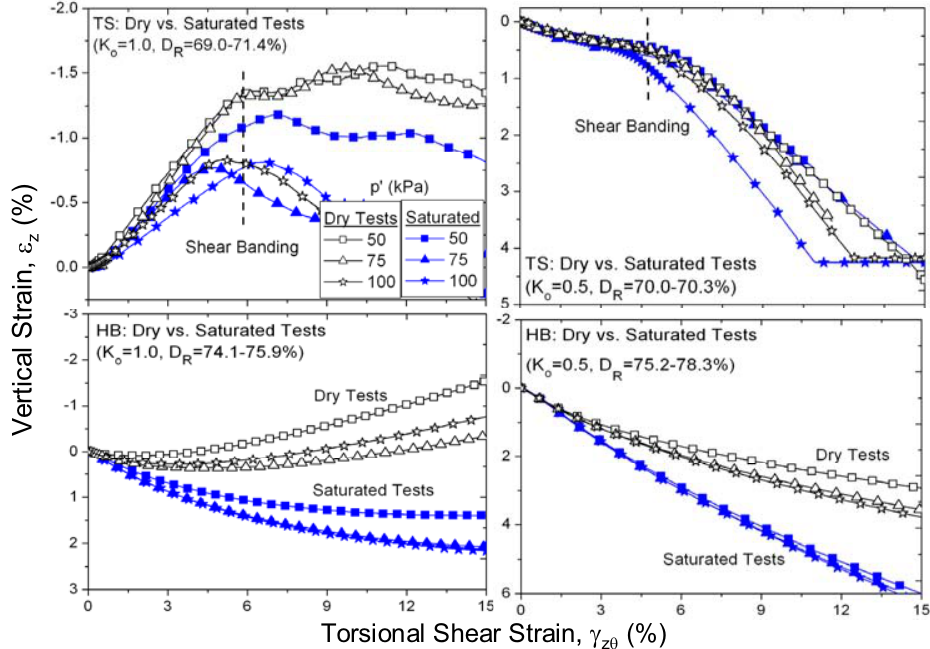
Fig. 14. Shear strain and vertical strain relationships during torsional shear.